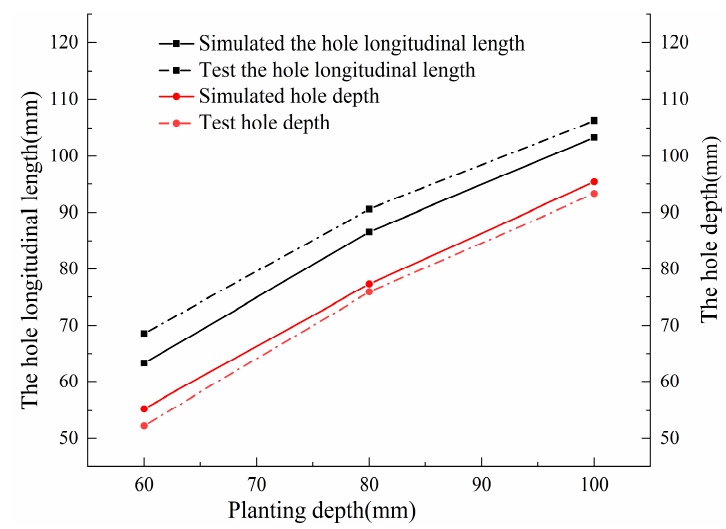
Figure 13. Variation curve of hole parameters at different planting depths.